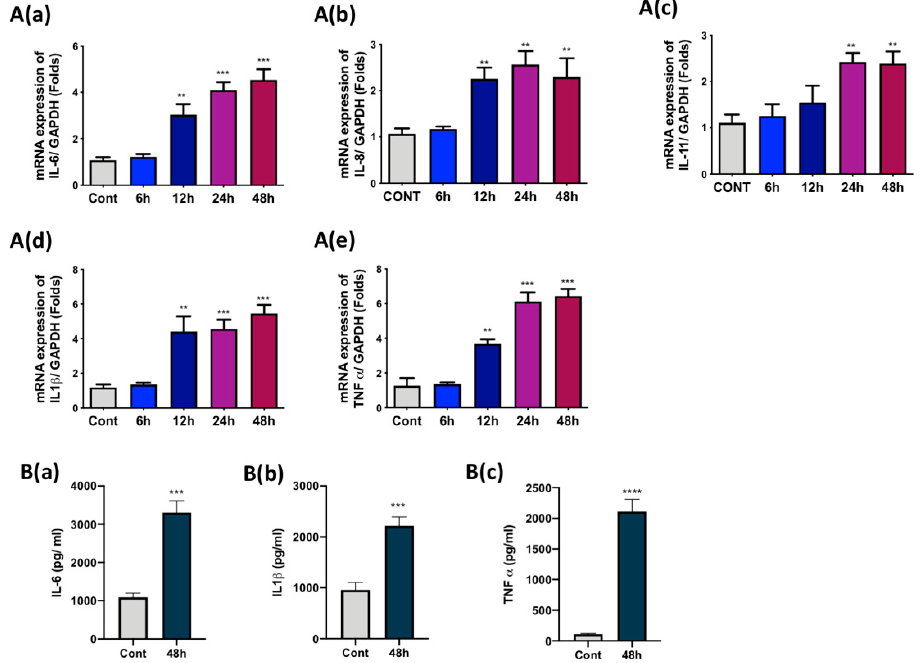
Figure 2. E ff ects of Ti particles on the secretion of pro-inflammatory cytokines from SW982 cells. Ti particles were used to treat (cell-to-particle ratio of 1:100) SW982 at several time points until 48 h. ( A ) RT-PCR analysis showed increased mRNA expression of ( a ) IL-6, ( b ) IL-8, ( c ) IL-11, ( d ) IL-1 β , and ( e ) TNF α . The mRNA expression of each targeted gene was normalized to glyceraldehyde 3-phosphate dehydrogenase (GAPDH). ( B ) ELISA results demonstrated enhanced secretion of pro-inflammatory cytokines such as ( a ) IL-6, ( b ) IL-1 β , and ( c ) TNF α in Ti-particle-stimulated SW982 medium. The results are demonstrated as means ± SDs of three independent experiments. In the graphical representations, ** p < 0.01, *** p < 0.001, and **** p < 0.0001 indicate significant di ff erences from the control group.